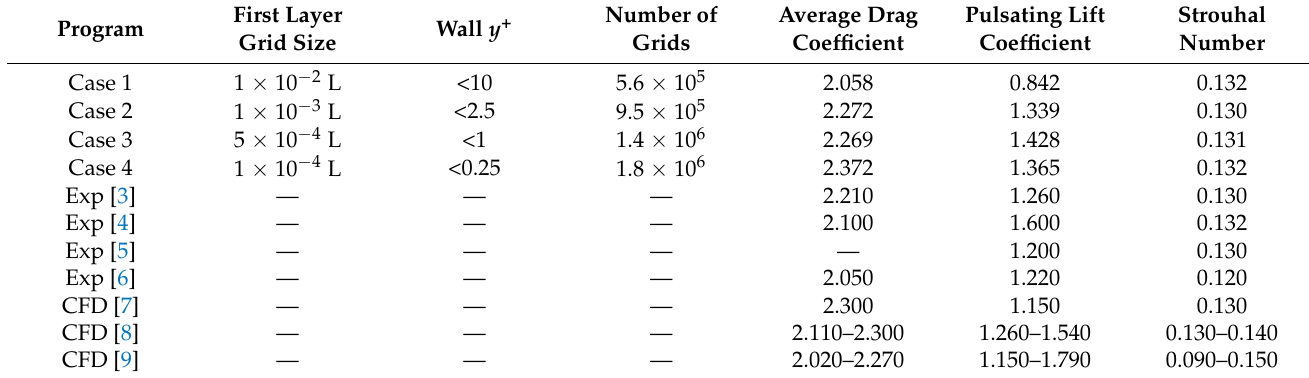
Table 1. Analysis of grid convergence and comparison of results.